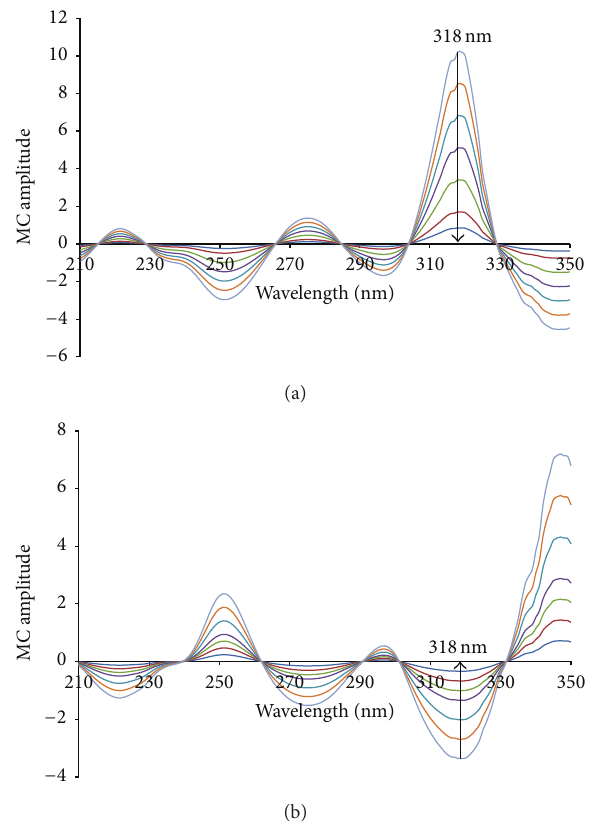
Figure 6: The mean centered ratio spectra of (a) 2.0–24.0 𝜇 g/mL diclofenac and (b) 2.0–20.0 𝜇 g/mL pantoprazole obtained using 4.0 𝜇 g/mL pantoprazole and diclofenac as a divisor, respectively, and methanol as a